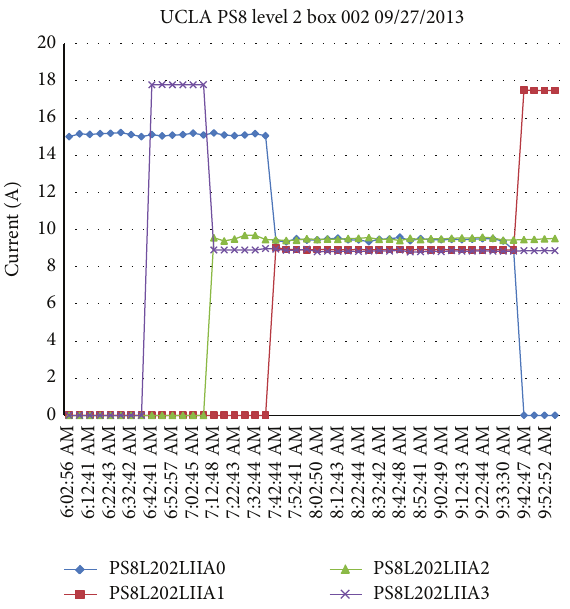
Figure 7: Example of simple current sharing algorithm.